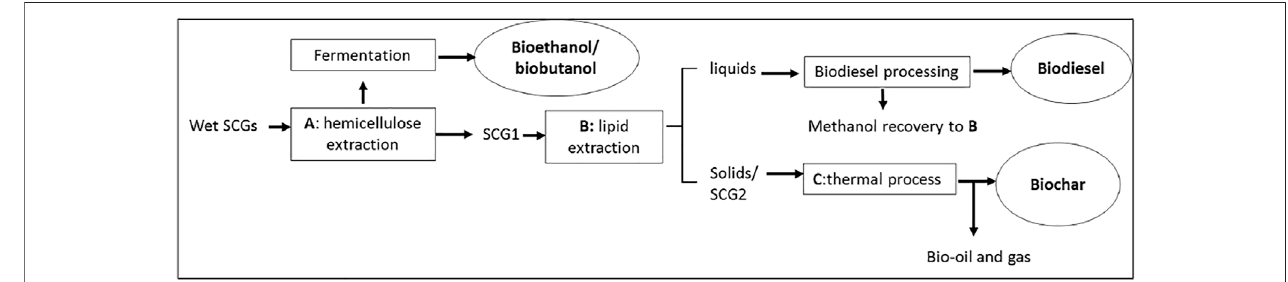
FIGURE 3 | A schematic diagram of SCG upcycle